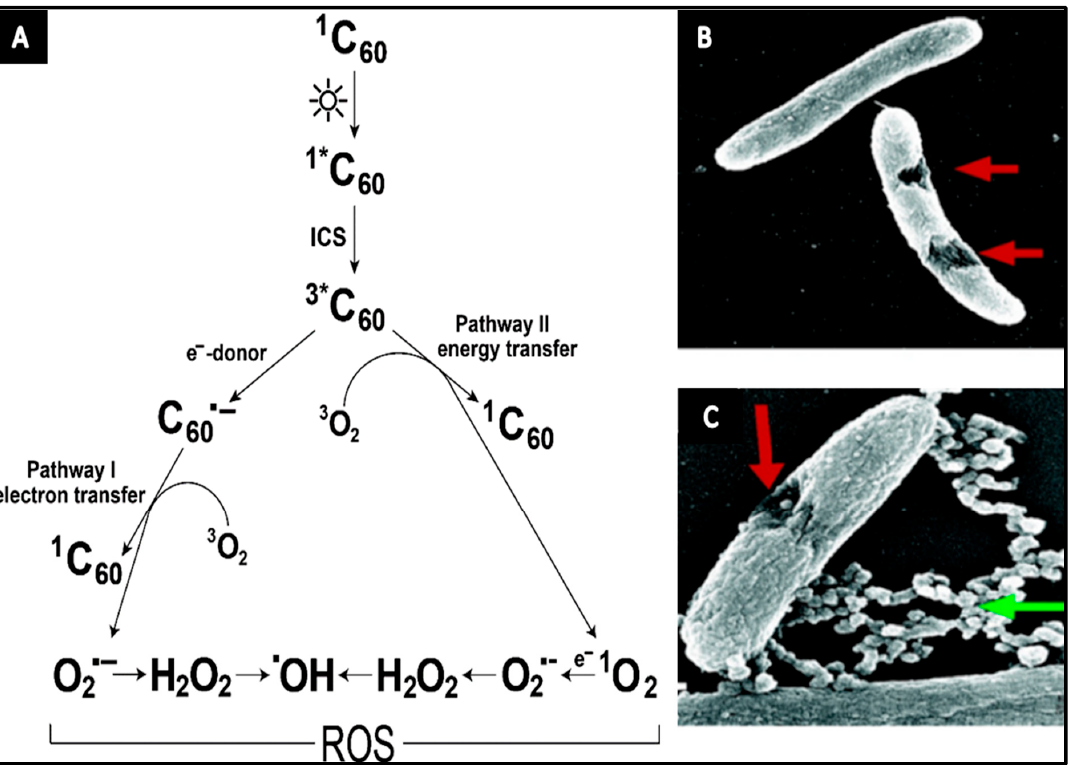
Figure 2. ( A ) Schematic representation of fullerene C 60 photochemical pathways leading to reactive oxygen species (ROS) generation. Reprinted with permission from Reference [46]; ( B , C ) SEM images of S. oneidensis MR-1 cells treated with C 60 − NH 2 show cellular damage. Cell samples were fixed for SEM images approximately 1 h after exposure to 20 mg/L C 60 − NH 2 . Green arrow points to nanoparticle aggregations and red arrow points to the damaged part of the cell. Reprinted with permission from Reference [56].